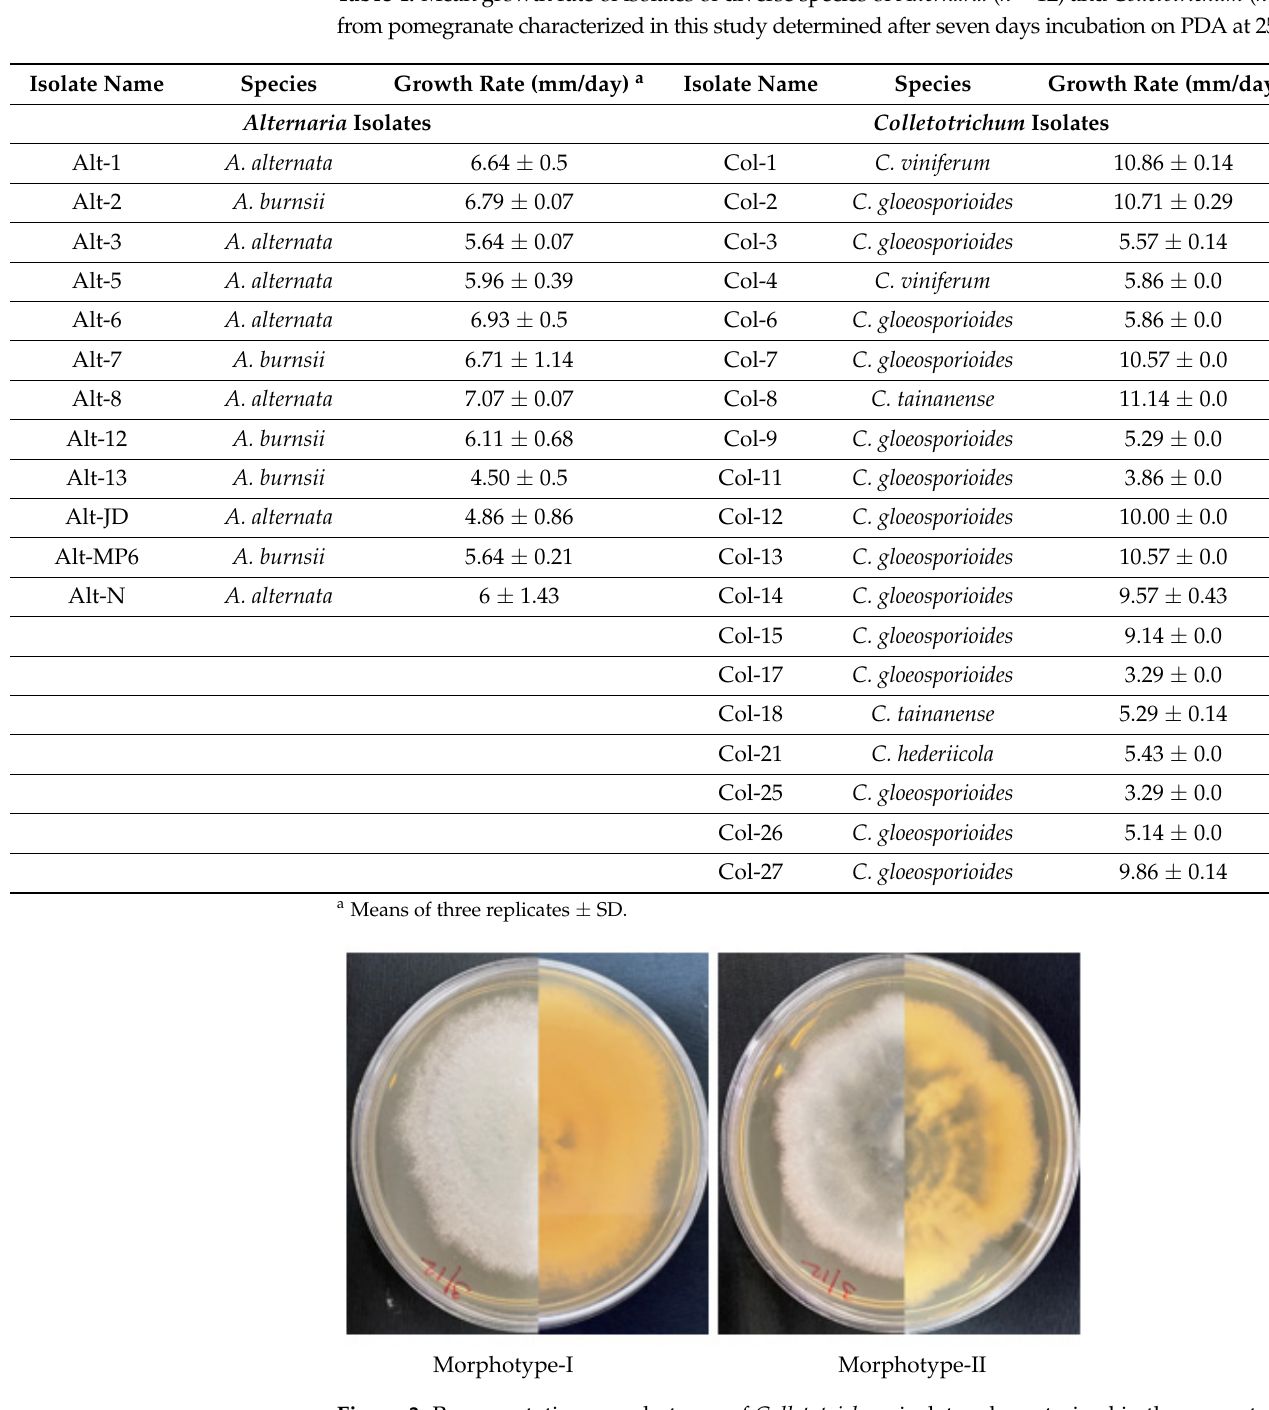
Figure 3. Representative morphotypes of Colletotrichum isolates characterized in the current study. Front and back of seven-day-old colonies grown on PDA at 25 °C. Table 4. Mean growth rate of isolates of diverse species of Alternaria ( n = 12) and Colletotrichum ( n = 19) from pomegranate characterized in this study determined after seven days incubation on PDA at 25 °C.